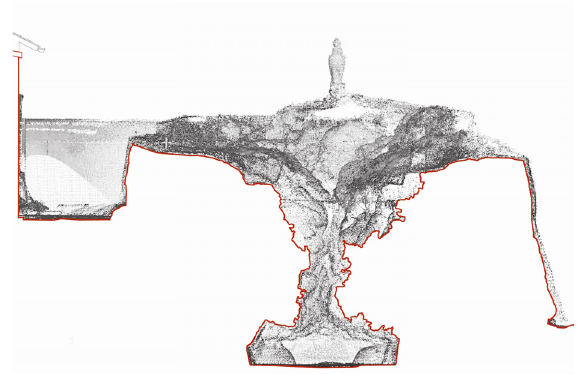
Figure 13. Section of the fountain